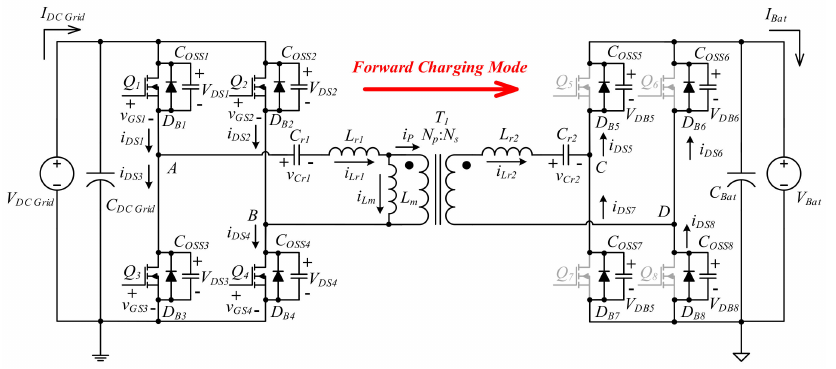
Figure 4. Power propagation of the forward charging mode.